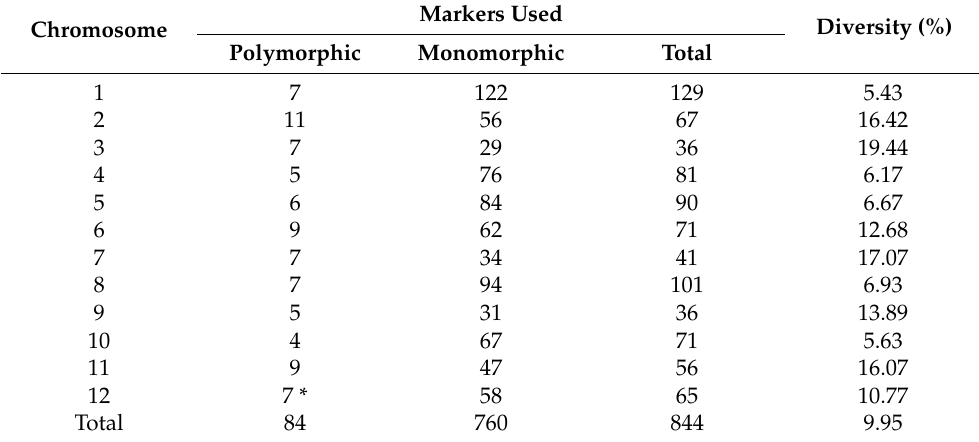
Table 1. Chromosome wise polymorphism between the parents, Pusa 44 and IR90019-22-28-2B.